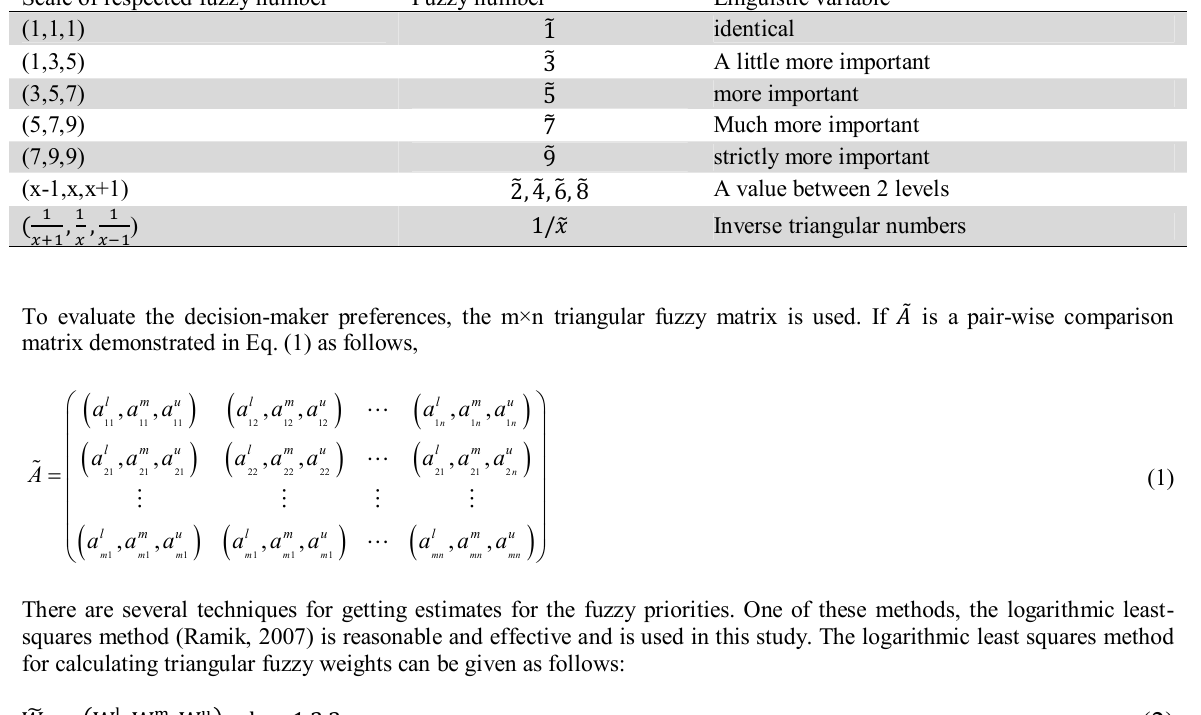
Linguistic variable Fuzzy number Scale of respected fuzzy number